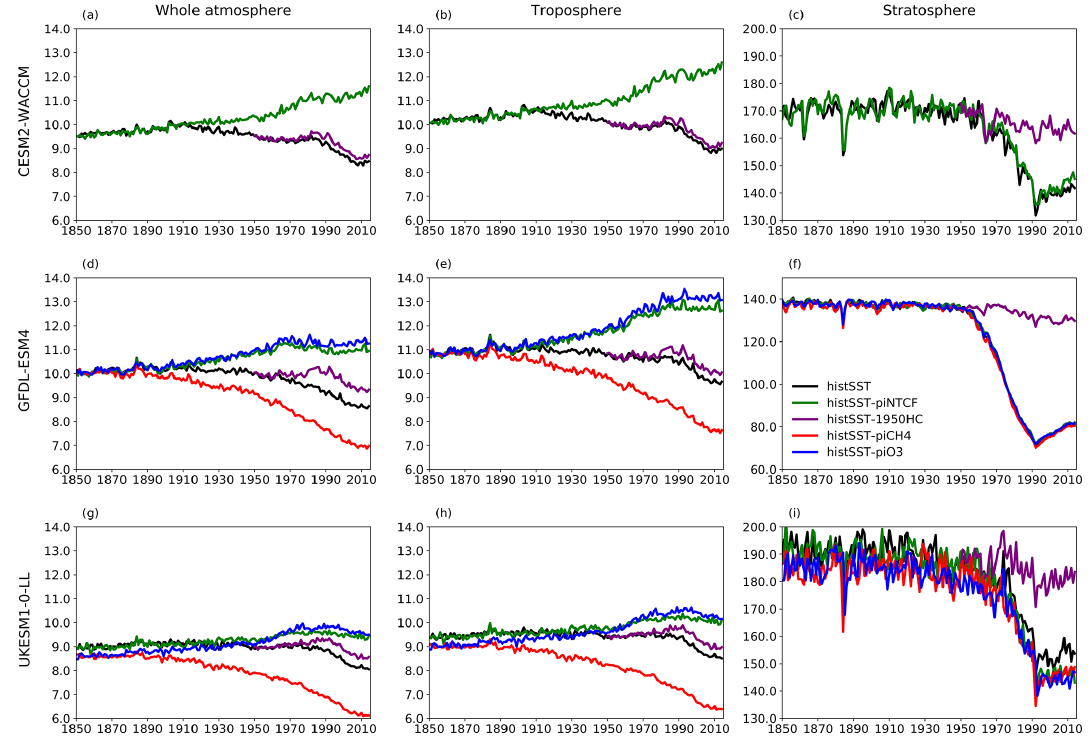
Figure 7. Time evolution (1850–2014) of CH 4 lifetime (years) for (a–c) CESM2-WACCM, (d–f) GFDL-ESM4, and (g–i) UKESM-0-LL averaged over the whole atmosphere (a, d, g) , the troposphere (b, e, h) , and the stratosphere (c, f, i) . Colours refer to different model experiments, as indicated in (f) . For UKESM-0-LL, we used historical-piNTCF as histSST-piNTCF was not